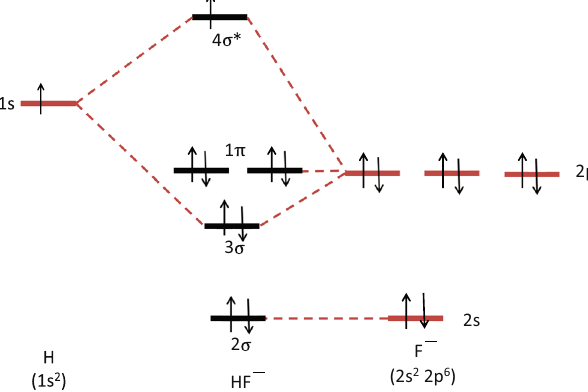
Figure 2. Qualitative molecular orbital diagram of HF − . The 2 σ orbital, coming from the F 2 s orbital, is non- bonding. The 3 σ orbital is a combination of the F 2p z and H 1 s orbitals and is bonding, whereas the F 2p x and 2p y orbitals cannot interact with the H 1 s orbital due to different symmetries and serve as non-bonding orbitals. The 4 σ * antibonding orbital is the counterpart of the 3 σ bonding orbital. From this diagram, the bond order of HF − is calculated to be 0.5.